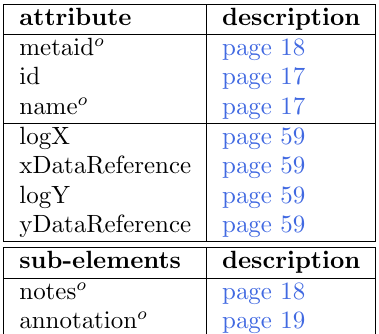
Table 2.28: Attributes and nested elements for curve. xy o denotes optional elements and attributes.